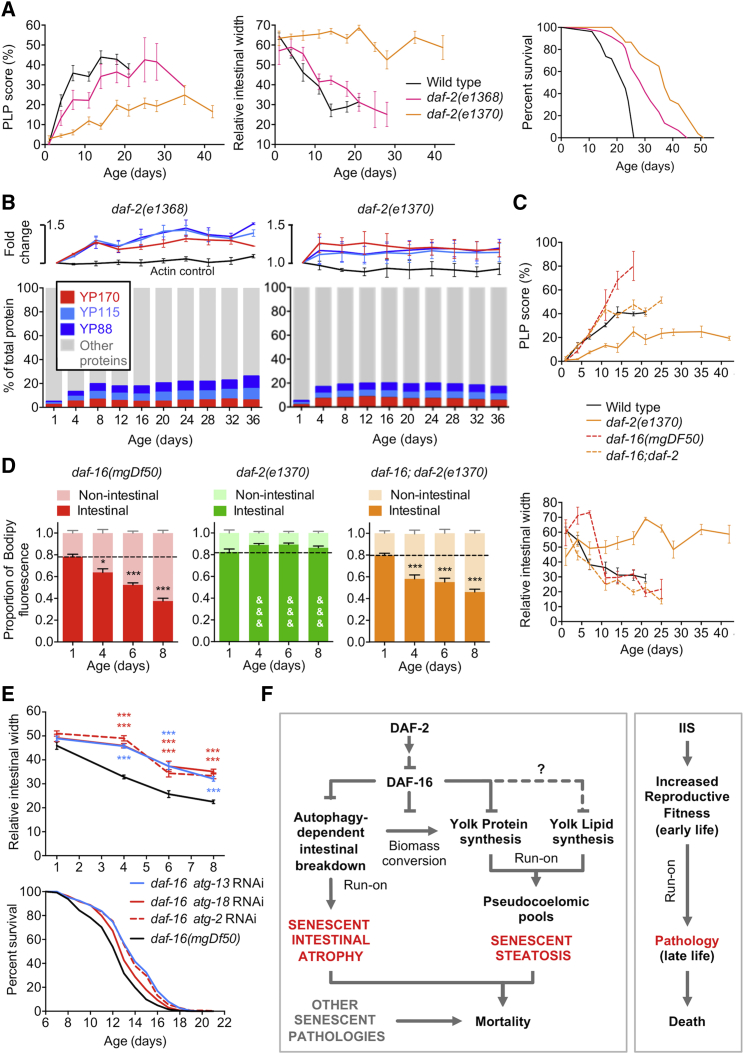
Reduced Insulin/IGF-1 Signaling Inhibits Gut-to-Yolk Biomass Conversion(A) PLP accumulation (left) and intestinal atrophy (center) are suppressed modestly by daf-2(e1368) and strongly by daf-2(e1370), which also has a larger effect on lifespan (right), confirming findings in a recent study [52].(B) YP levels and YP as proportion of total protein in daf-2(e1368) (left) and daf-2(e1370) (right) (cf. Figures 2F and 3B).(C) PLP accumulation (top) and intestinal atrophy (bottom) in daf-2(e1370) require daf-16; N = 2 trials.(D) Age-associated neutral lipid redistribution (Bodipy) is suppressed in daf-2(e1370) mutants, and this requires daf-16. ∗p < 0.05, ∗∗∗p < 0.001, &&&p < 0.001, compared to age-matched daf-16, daf-16; daf-2, or wild-type (cf. Figure 3G).(E) RNAi of atg-2, atg-13, and atg-18 all suppress intestinal atrophy (top), whereas atg-2 and atg-13 also increase lifespan (bottom; p < 0.01 all trials; N = 2 and 5, respectively) in a daf-16(mgDf50) mutant (25°C, FUDR). ∗∗∗p < 0.001.(F) Proposed mechanism of antagonistically pleiotropic action of IIS promoting reproduction at the expense of senescent pathologies, through gut-to-yolk biomass conversion.See also Figure S7.